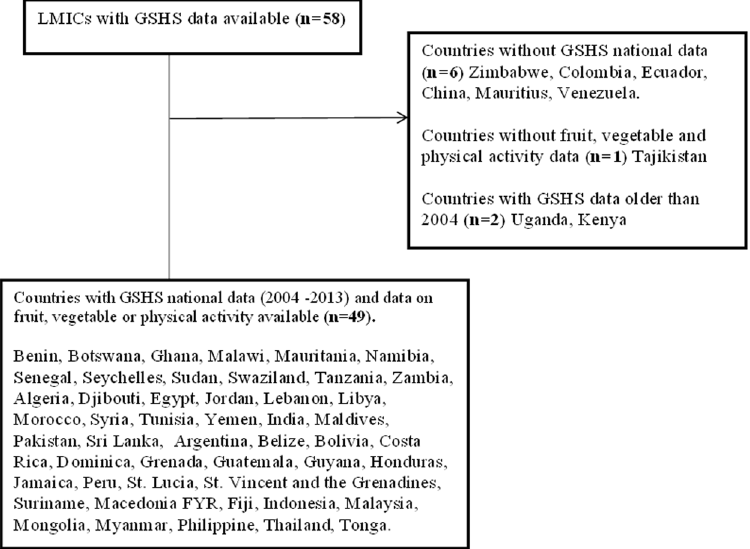
Figure 1. Selection process for LMICs based on available GSHS national data between